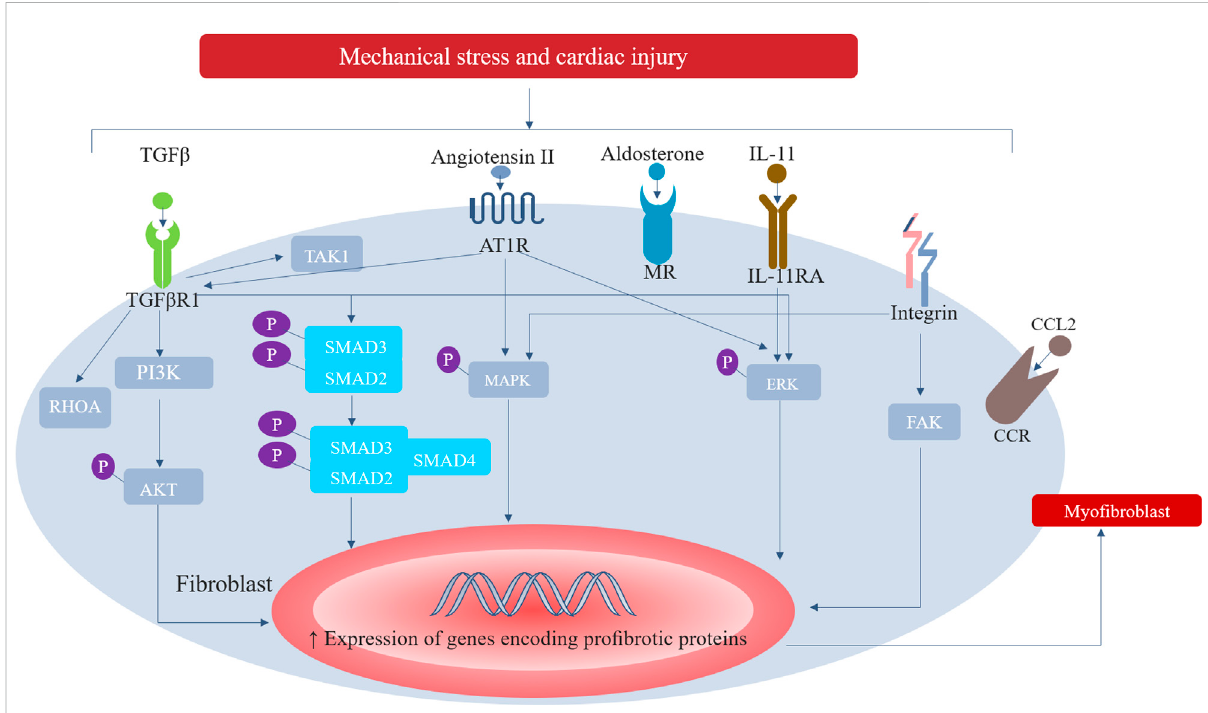
FIGURE 1 Major signalling pathways involved in the activation of cardiac fi broblasts. In response to increased mechanical stress and to cardiac injury, in fl ammatorysignallingcascades(triggeredbycytokinesandchemokines),mechanosensitivemechanisms(mediatedbyintegrinsandionchannels), and neurohumoral pathways (such as renin-angiotensin-aldosterone system) can activate fi broblasts into extracellular matrix-synthesizing myo fi broblasts. Among them, TGF- β is the main regulator of fi brogenesis through SMAD-dependent pathway and none-canonical signal cascade. Ang II also plays an important role in cardiac fi brosis, which activates pro fi brotic cascades, such as TGF- β /SMAD, ERK1/2, AKT and MAPK. AT1R,type1angiotensinIIreceptor;CCL2,CC-chemokineligand2;CCR,CC-chemokinereceptor;ERK,extracellular-signal-regulatedkinase;FAK, focal adhesion kinase; IL-11RA, IL-11 receptor subunit- α ; MAPK, mitogen-activated protein kinase; MR, mineralocorticoid receptor; PI3K, phosphoinositide 3-kinase; RHOA, transforming protein RHOA; TAK1, TGF β -activated kinase 1; TGF β R1, TGF β receptor type 1.